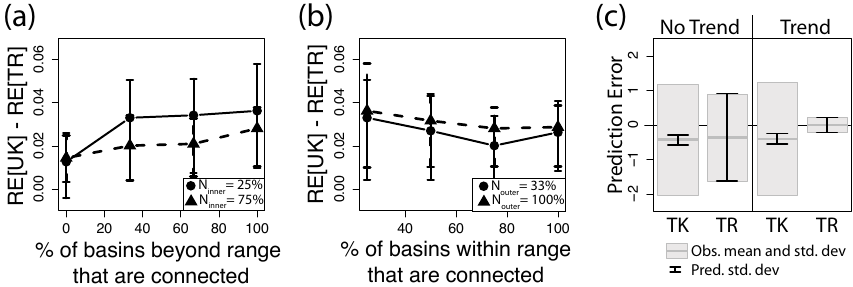
Figure 6. Results of the Monte Carlo experiments. (a) and (b) display the effect of network complexity on the performance of TopREML relative to universal kriging. Network complexity is given as the ratio of basins beyond ( N outer ) and within ( N inner ) the spatial correlation range that are flow-connected – minimum network complexity is modeled when no basins beyond and all basins within the range are flow- connected. Relative performance is computed at each Monte Carlo run as the difference in relative prediction errors between universal kriging and TopREML (i.e., RE [ UK ]− RE [ TR ] on (a) and (b) ). The graphs display the expectation and standard deviation of that difference over the 1000 Monte Carlo runs. (c) presents the observed (grey boxes) and predicted (black error bars) standard deviation on the prediction errors for Top-kriging (TK) and TopREML (TR). Note that the slight downward biases that appear on the graph remain below 1% of the expected value of the predicted